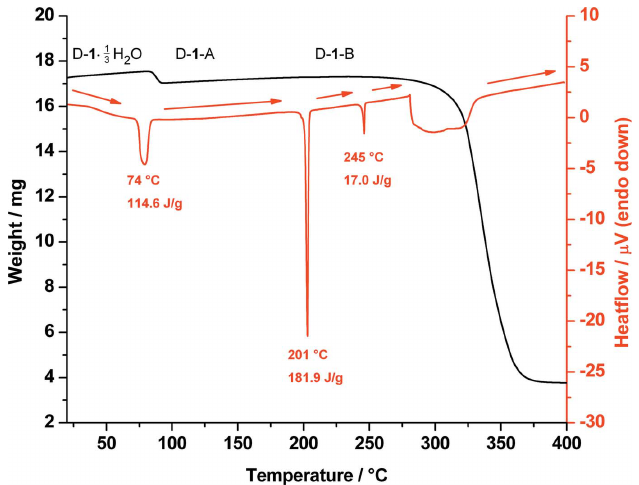
Figure 2 Combined DSC (red) and TGA (black) traces of the 1/3 hydrate of d